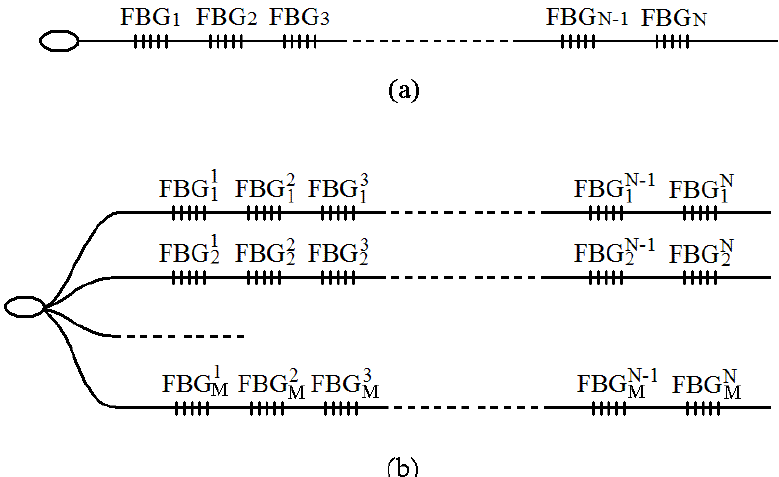
Figure 2. Network topology of the FBG sensing system. ( a ) Single line structure; ( b ) Multi-line